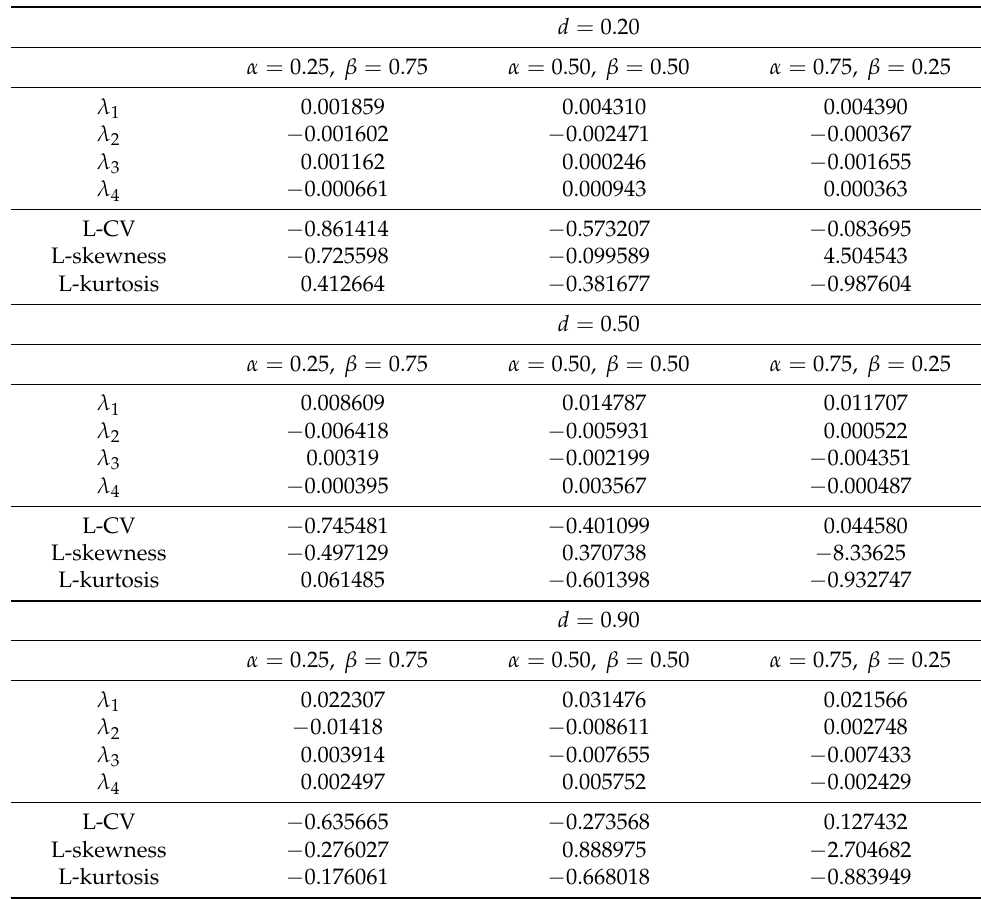
Table 2. L-moments of the omega distribution for several parametric